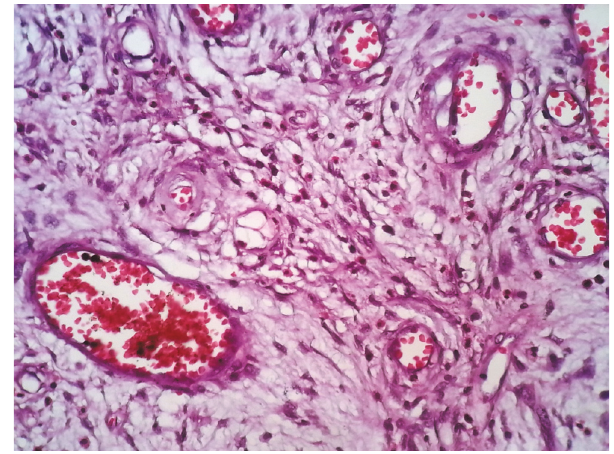
Figure 4: H&E stain demonstrating an associated abundant inflam- matory infiltrate dominated by